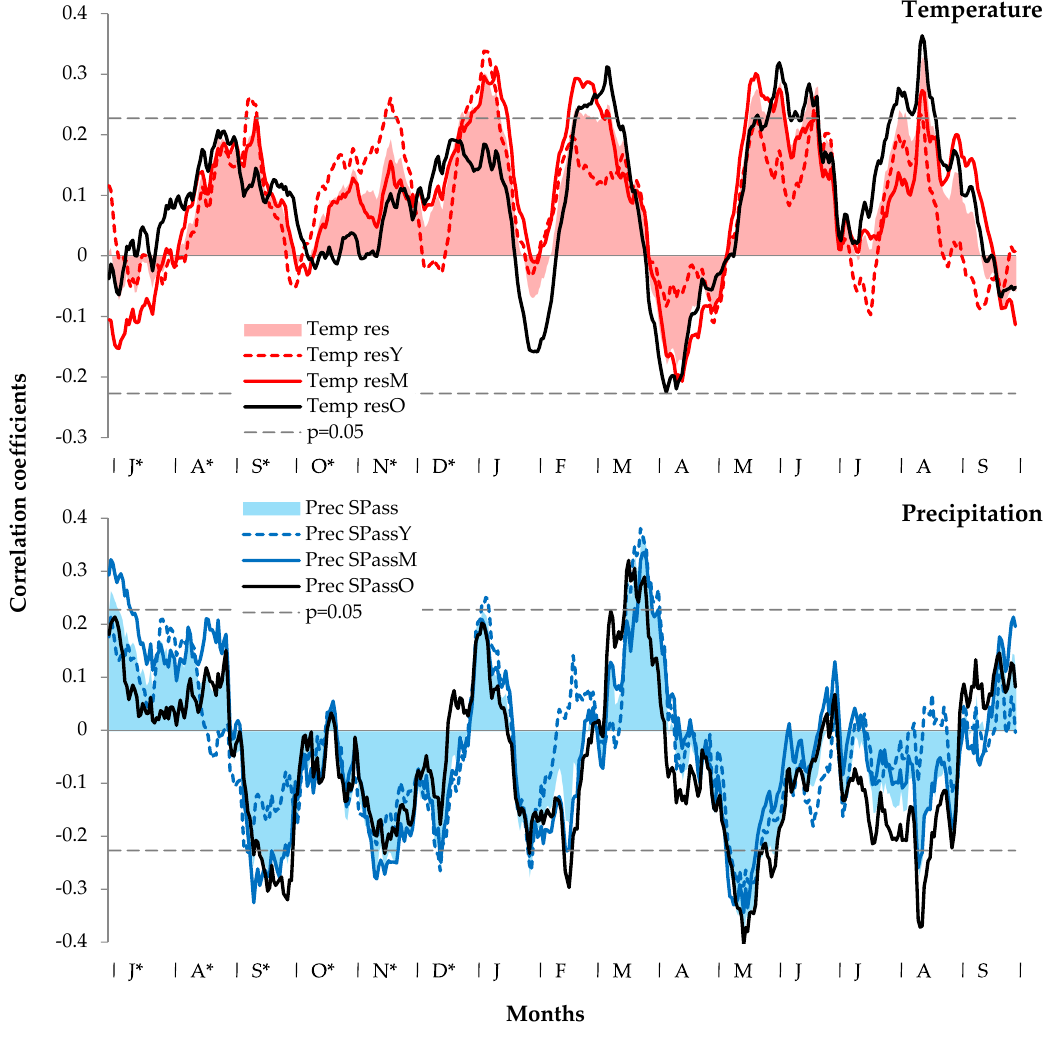
Figure 5. Climatic response of P. sibirica trees at the SPass sampling site for various ages: correlations between 21-day temperature (Temp, red) and precipitation (Prec, blue) series (1936–2010) and residual chronologies of young (SPassY, dashed color line), middle-aged (SPassM, solid color line), and old (SPassO, solid black line) tree groups, and total sample (SPass, shaded area). Asterisks mark months of previous year. Dashed thin horizontal lines represent significance level p = 0.05.